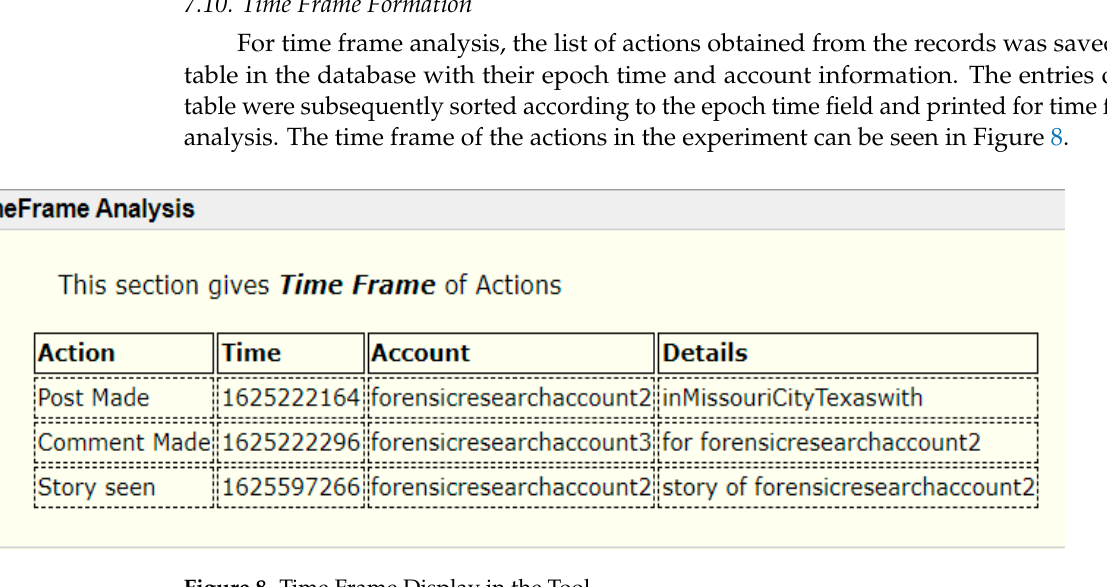
Figure 8. Time Frame Display in the